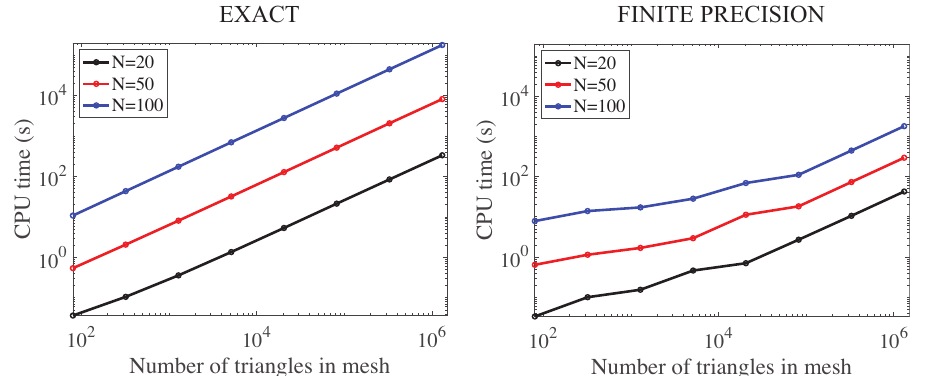
Figure 12. CPU times required to compute the Zernike moments of a sphere as a function of the number of triangles in the meshes that represent this sphere. We compare the exact algorithm ( left ) with the finite precision algorithm ( right ), while the time complexity for the former is found to be strictly linear with respect to the number of triangles, it deviates from linearity for the latter. We observe the same behavior for different maximum order N (20, 50 and 100) at which the Zernike moments are